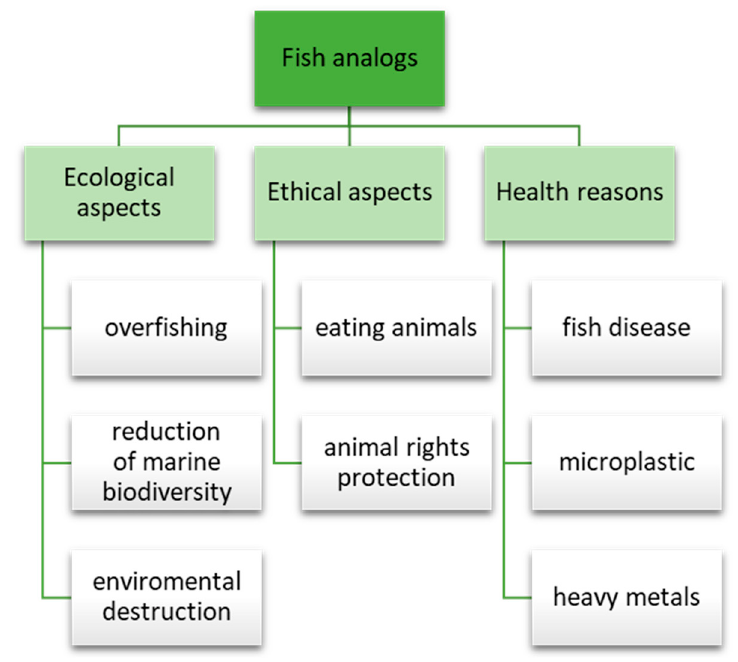
Figure 1. Reasons for interest in fi sh analogs.